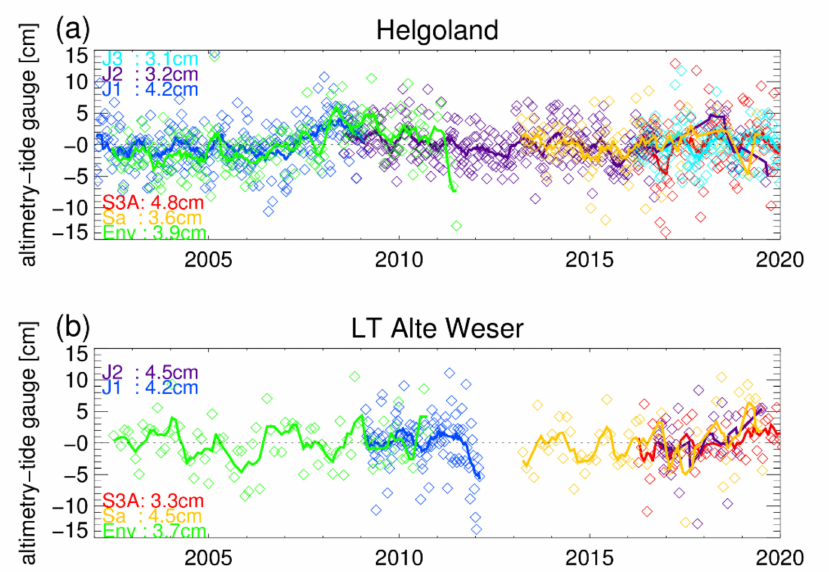
Figure 6. Difference between altimetry and tide gauge at stations ( a ) Helgoland (open water) and ( b ) LT Alte Weser (coastal) for up to six missions (color coded) with time variable position correction applied. Diamonds mark single measurements, thick lines are the 3 months box-car filter, RMS-D values are given at the left-hand side and missions are color